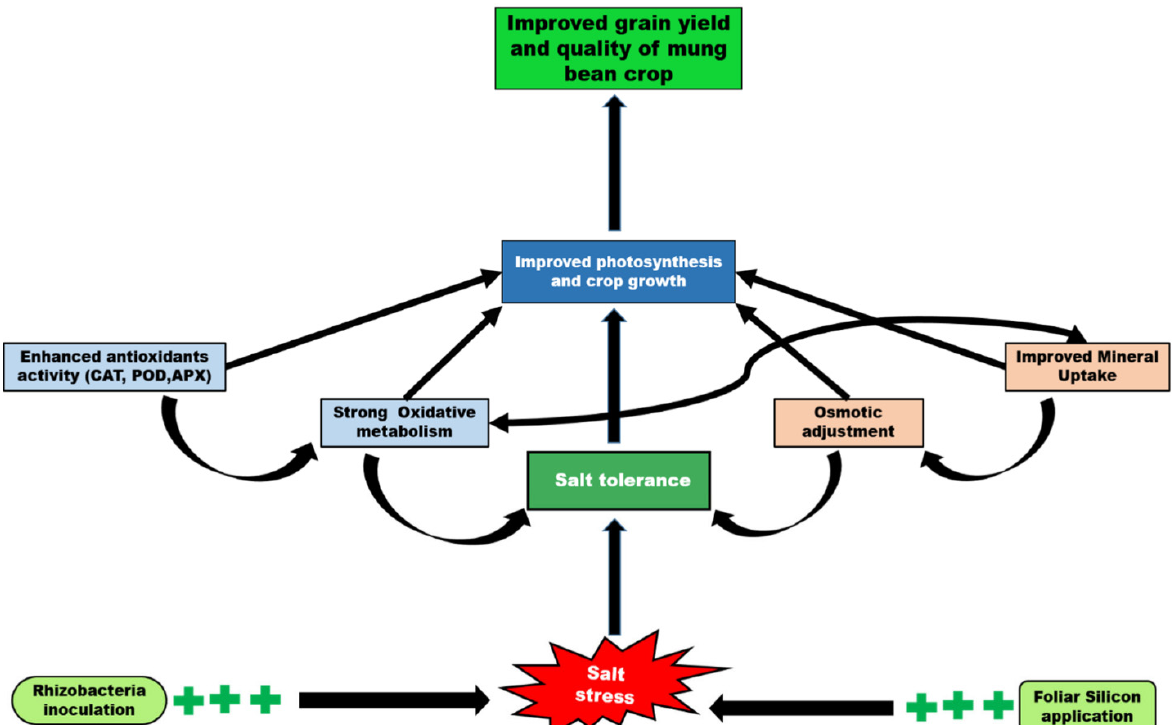
Figure 4. Schematic representation of possible mechanism of salt tolerance in mung bean crop induced by the synergistic effect of silicon (Si) and plant growth promoting bacteria (PGPR). The syn-